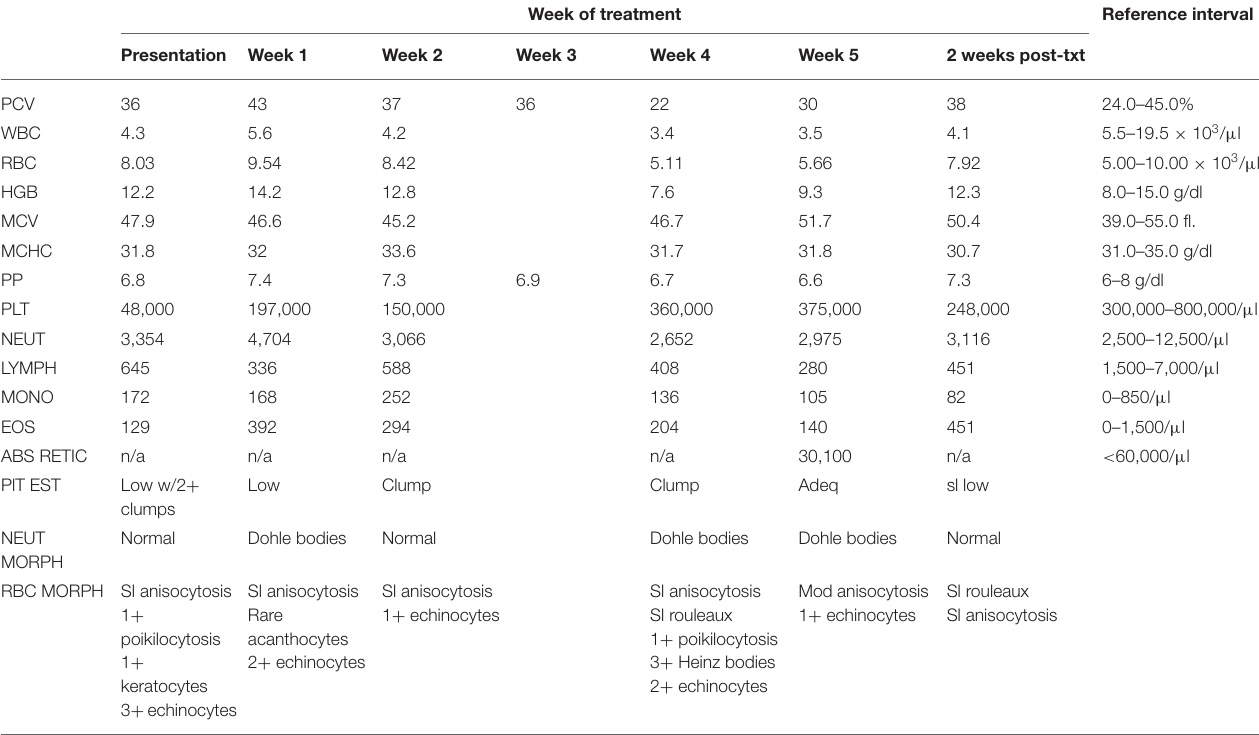
TABLE 1 | Hematologic changes seen in a 9 years old cat during repeated anesthesia with propofol.